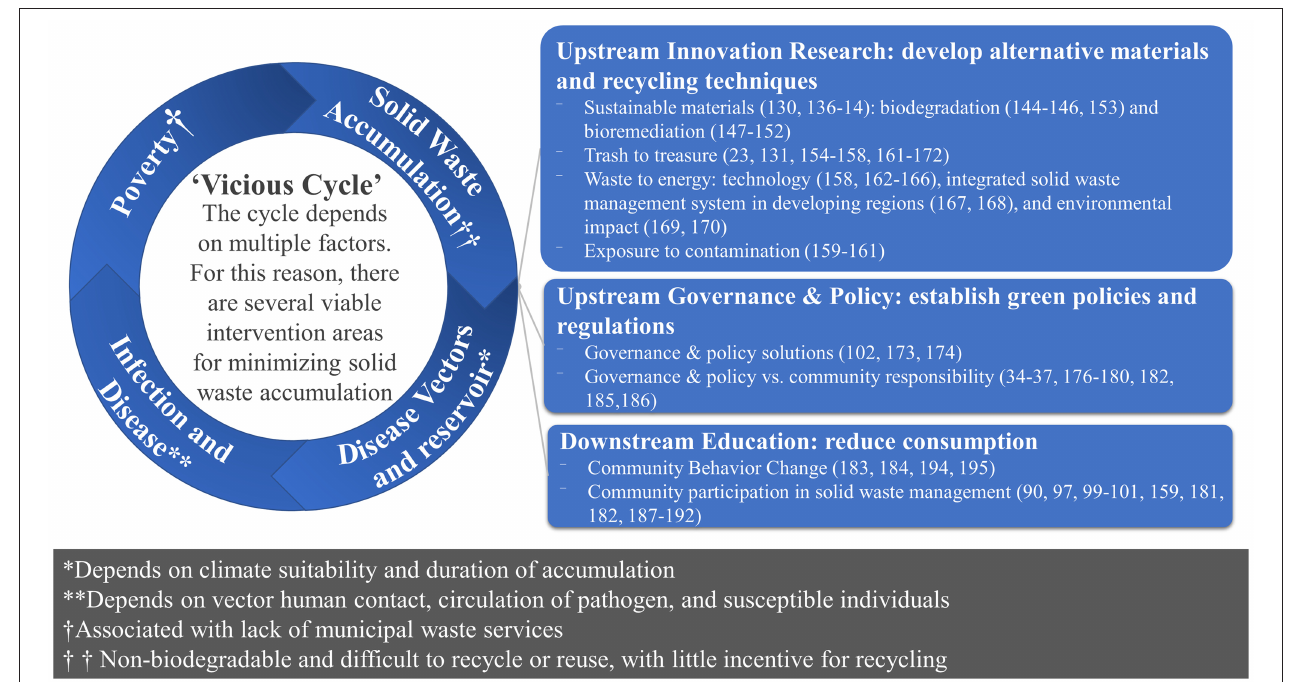
FIGURE 1 | Framework for solutions-based research: upstream innovation research, upstream governance and policy, and downstream education. Recognizing that the current practices and incentive structures that drive these practices are inadequate to address the volume of trash generated globally, different approaches are needed to manage the growing waste problem. Notes for the symbols in the circle. Disease vectors and reservoirs *Depends on climate suitability and duration of accumulation; Infection and Disease **Depends on vector human contact, circulation of pathogen, and susceptible individuals; Poverty is † Associated with lack of municipal waste services; Solid waste accumulation refers to †† Non-biodegradable materials which are not incentivized for